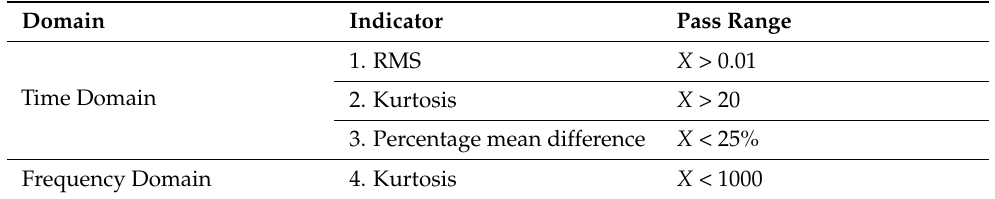
Table 1. Criteria used for data filtering.